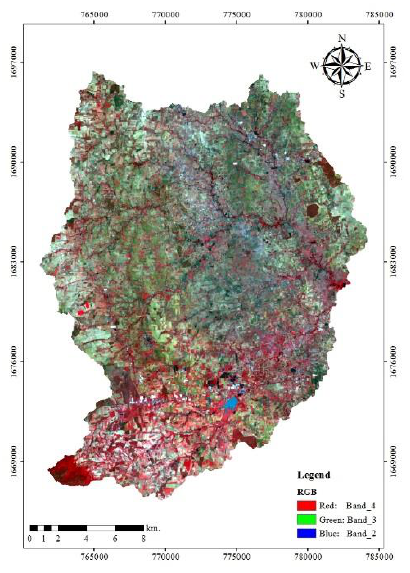
Figure 1. Landsat 8 data of the study area Figure 2. Workflow diagram of the research